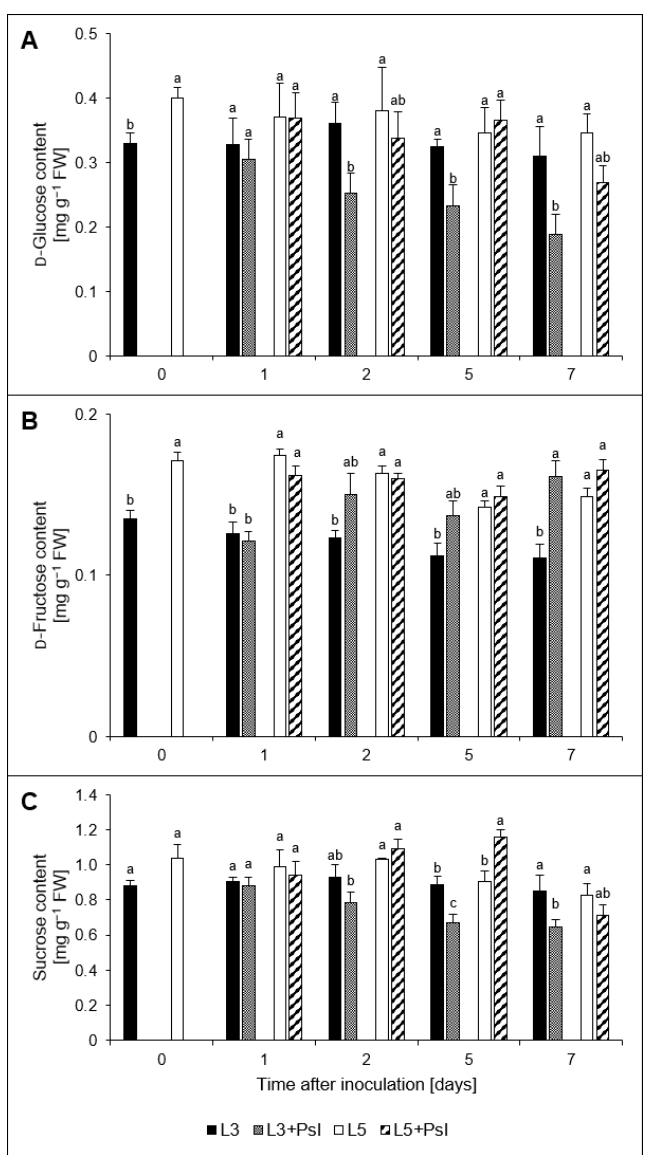
Figure 2. Changes in ( A ) D -glucose, ( B ) D -fructose, and ( C ) sucrose contents in cucumber leaves after P. syringae pv lachrymans infection. Values are means of five replicates (±SD). Different letters (a–c) indicate significant ( p ≤ 0.05) differences between experimental variants at a given time point.